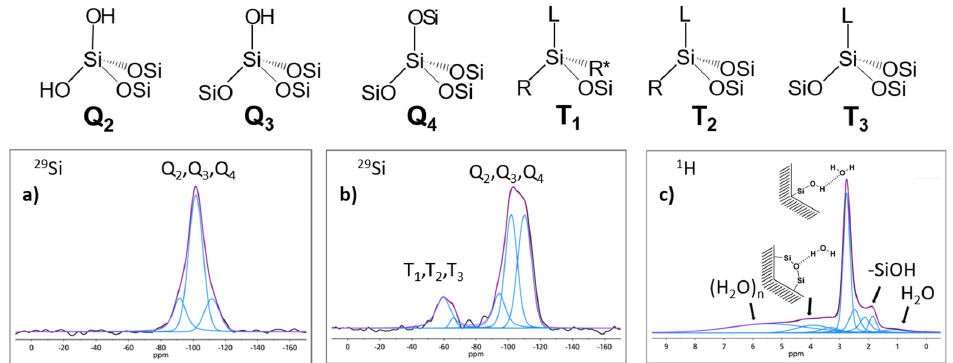
Figure 1. Upper panel: Different types of silica sites. Lower panel: 29 Si CPMAS (10 kHz) spectra of ( a ) neat and ( b ) functionalized silica, showing the appearance of T n -groups by the functionalization. (adapted from Weigler et al. [181]). ( c ): 1 H SSNMR spectrum of a non-dried MCM-41 at 10 kHz (black). Deconvolution (blue), sum of deconvolution (magenta) and assignment of water species to the peaks [36].